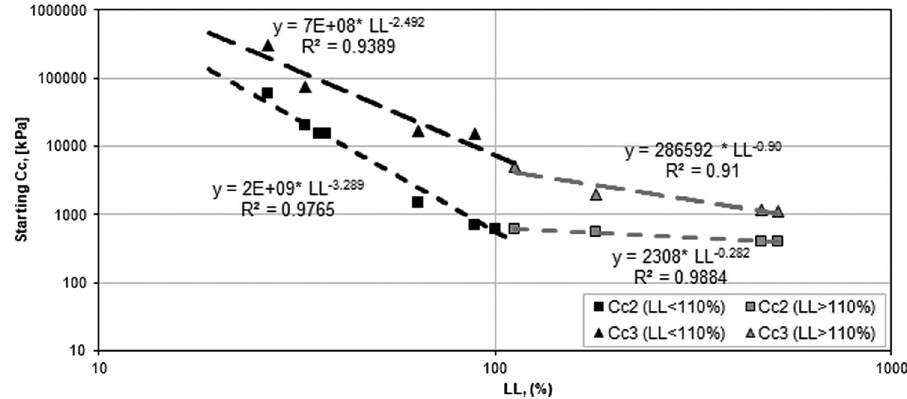
Figure 12: Best - fi t relationship of stress for starting C c2 and C c3 vs complete range of LL.